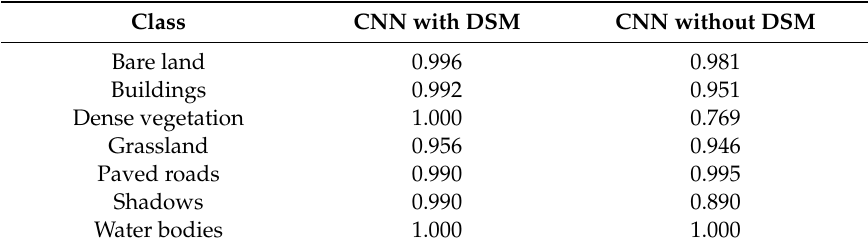
Table 3. Per-class accuracies (PA) for the training